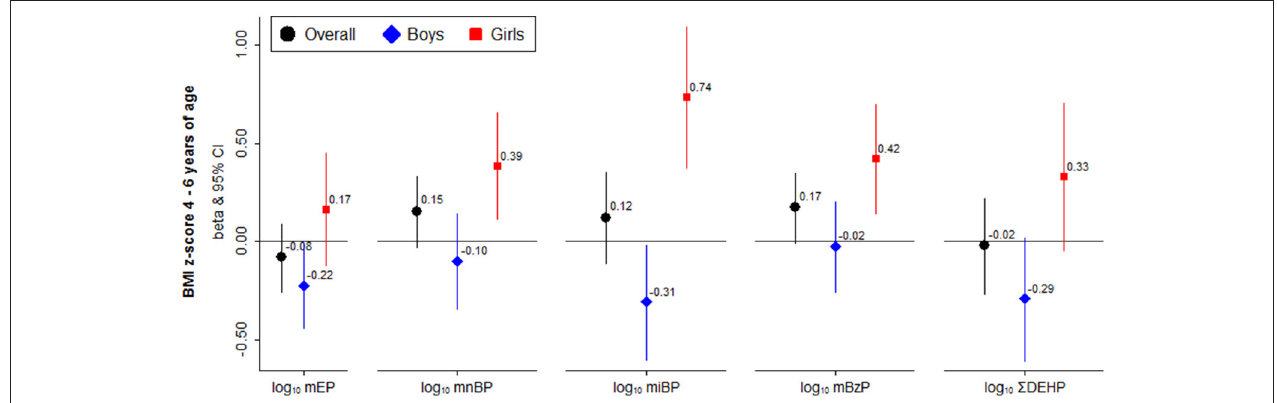
FIGURE 1 | Sex-stratified associations between child urinary individual and summed Σ DEHP phthalate metabolites (log 10 Transformed, in µ g/g Creatinine) with child BMI z scores at 4 to 6 years of age. All models are adjusted for child sex, exact age at examination, and maternal characteristics (age at delivery, parity, education, pre-pregnancy BMI, and smoking in